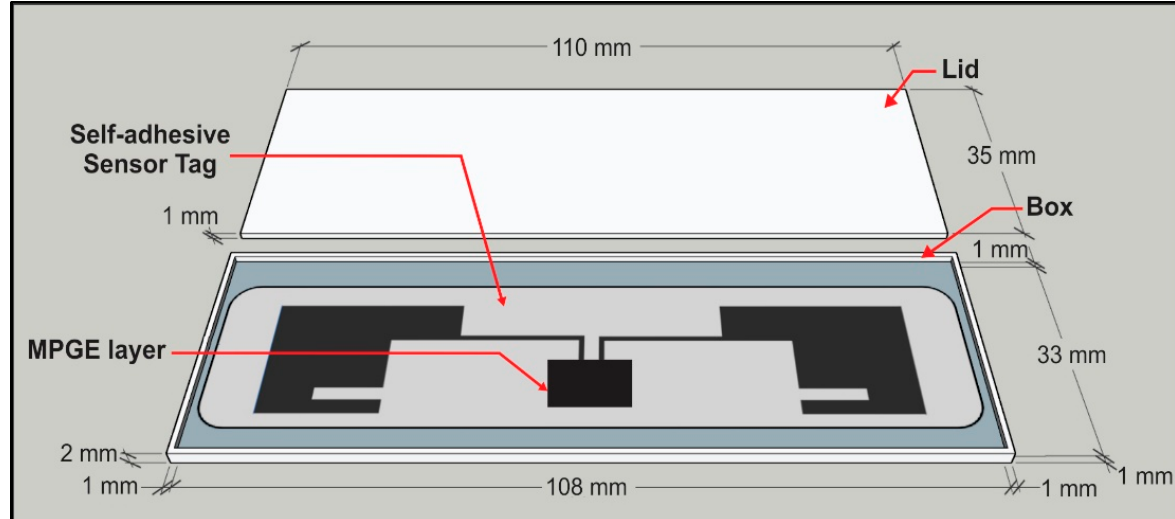
Table 1. Comparison of material properties of each specimen.